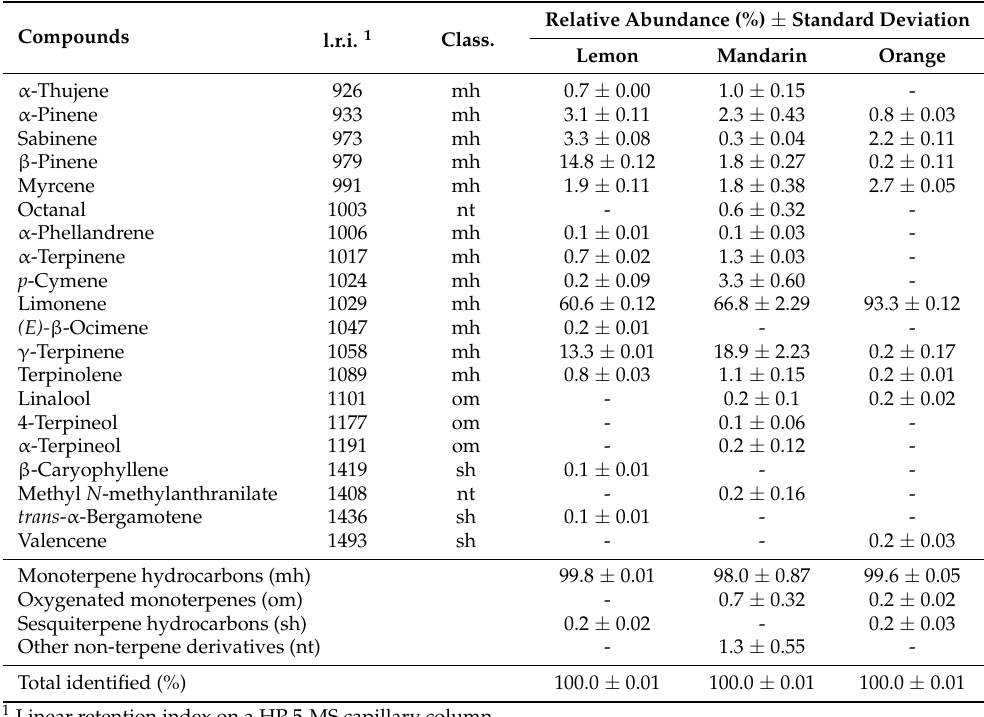
Table 7. Complete composition of the headspaces of fresh lemon, mandarin, and orange fruits.